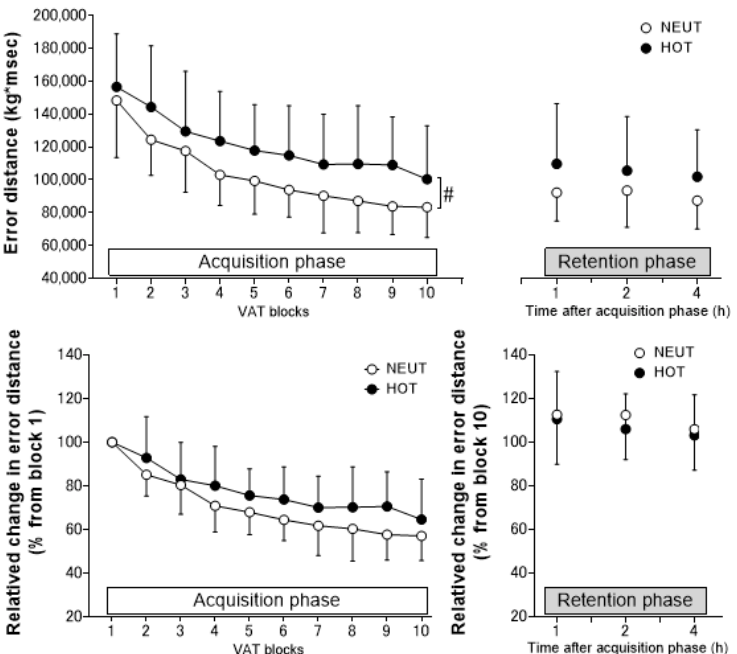
Figure 2. Absolute and relative changes in error distance during the acquisition and retention phases in thermoneutral (NEUT, n = 14) and hot (HOT, n = 15) environments. Values are presented as means ± SD. #, the main effect of environmental condition ( p = 0.050).